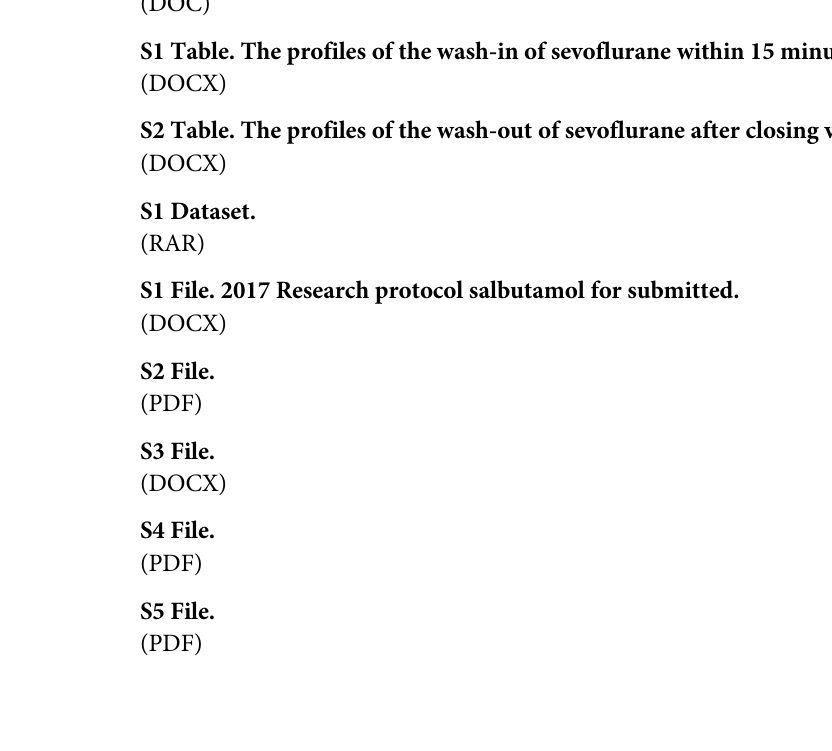
S2 Table. The profiles of the wash-out of sevoflurane after closing